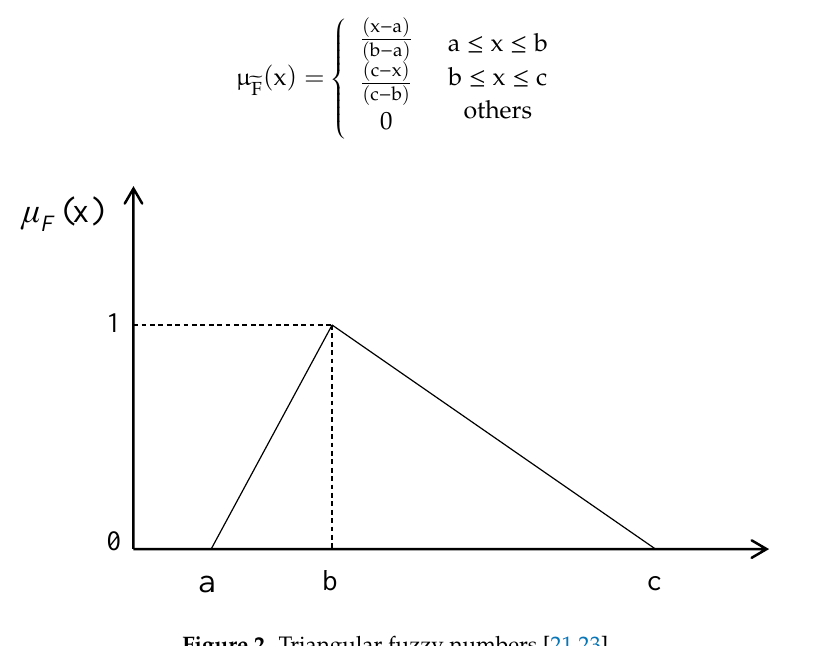
Figure 2. Triangular fuzzy numbers